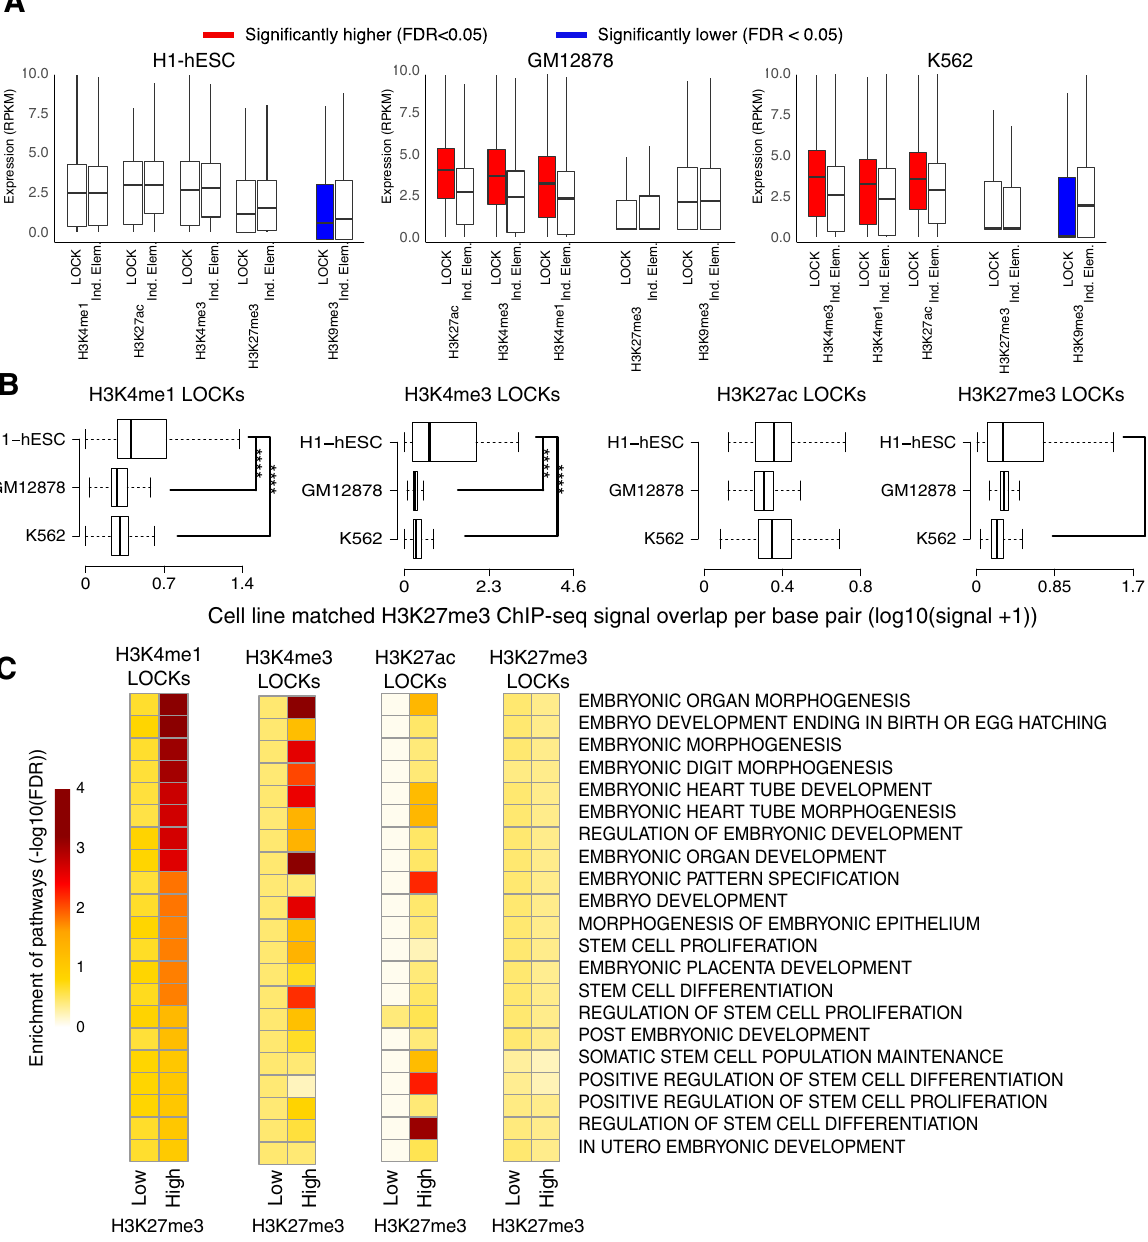
Fig. 4 Bivalent LOCKs are observed only in primitive cell types and associated with genes repressed in primitive cell types. A Expression level of genes in proximity of LOCKs versus individual regions (Ind. elements) marked by H3K4me1, H3K4me3, H3K27ac, H3K9me3 or H3K27me3 in the primitive H1- hESC versus differentiated GM12878 and K562 cell types. The boxplots represent the distribution of the expression level of genes (The boxes correspond to the upper and lower quartiles from the median de fi ned by the horizontal line. The whiskers represent the variability outside in gene expression found above or below the quartiles). B Quanti fi cation of H3K27me3 ChIP-seq signal overlap in LOCKs of active histone modi fi cations (H3K4me1, H3K4me3 and H3K27ac) for H1-hESC, GM12878 and K562 cell types. The signal is normalized (divided by median) to the H3K27me3 ChIP-seq signal overlapped in the Ind. elements of the corresponding pro fi les in each cell line. Wilcoxon signed-rank test was used to compare distribution of signals in different cell lines (*FDR < 0.05; ****FDR < 0.0001). The boxplots depict the distribution of overlapped ChIP-seq signal bound to be greater than zero and median to be less than 1 (The boxes correspond to the upper and lower quartiles from the median de fi ned by the horizontal line. The whiskers represent the variability outside the lower and upper quartiles). C Gene set enrichment analysis (GSEA) reporting the enrichment of pathways in active LOCKs (H3K4me1, H3K4me3 and H3K27ac) and LOCKs of H3K27me3 repressive mark associated or not with elevated H3K27me3 signal in the H1-hESC primitive cell type. In this analysis, the catalogue of genes associated with all the individual elements, with corresponding H3K27me3 signal level, were used as background gene